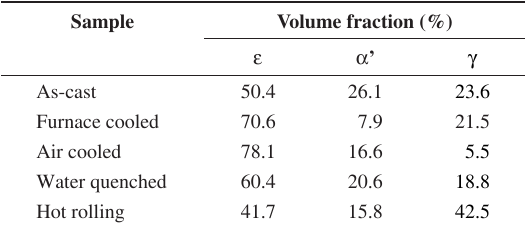
Table 3. Phase volume fractions of samples measured by X-ray diffraction. Sample